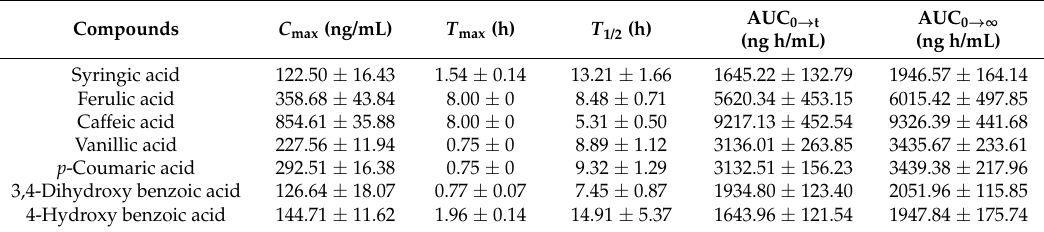
Figure 3. Mean concentration-time profiles of the seven analytes in rat plasma after oral administration of E. purpurea extract ( n = 12, mean ± SD). Table 4. Pharmacokinetic parameters of the seven compounds in rat plasma after oral administration of E . purpurea extract ( n = 12, mean ± SD).